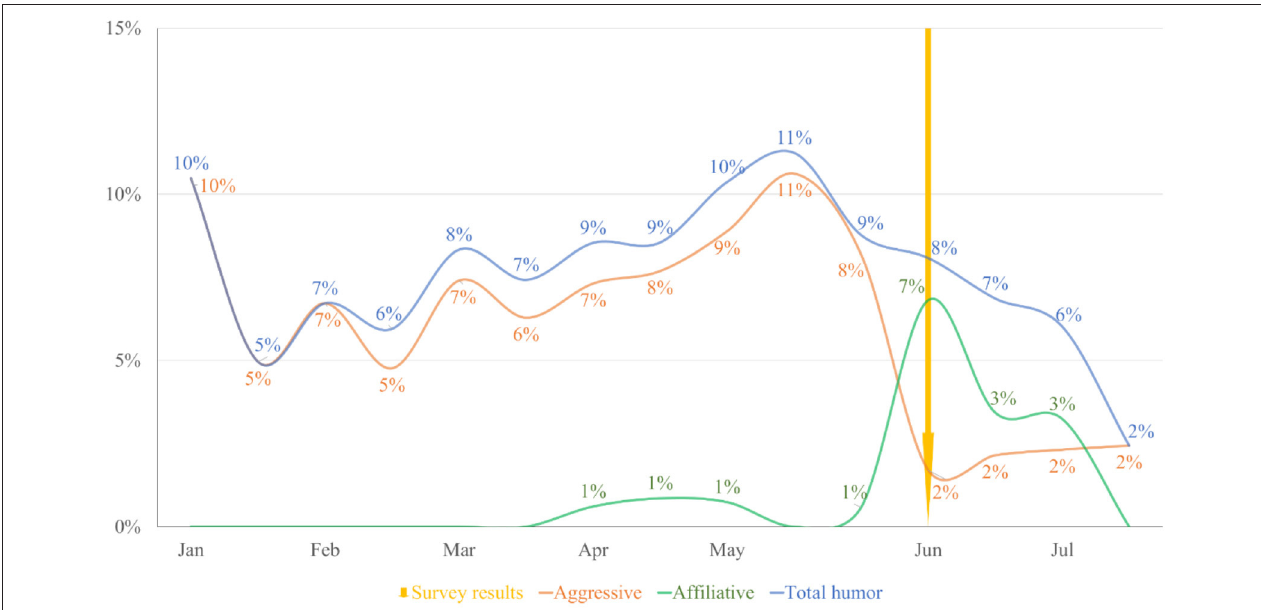
FIGURE 1 | Percentage of humorous, affiliative, and aggressive tweets of all the considered political figures. We present rounded percentages with no decimals to facilitate the interpretation of the figure.